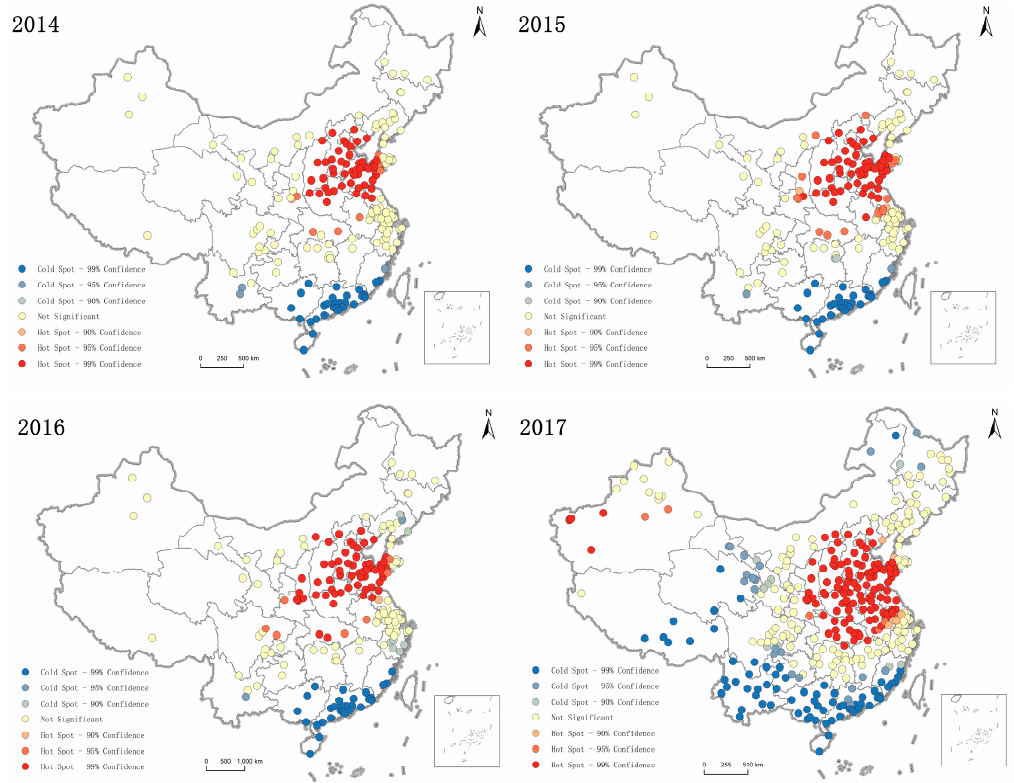
Figure 6. Spatial distribution of cold and hot spots with PM 2.5 concentration during 2014–2017.